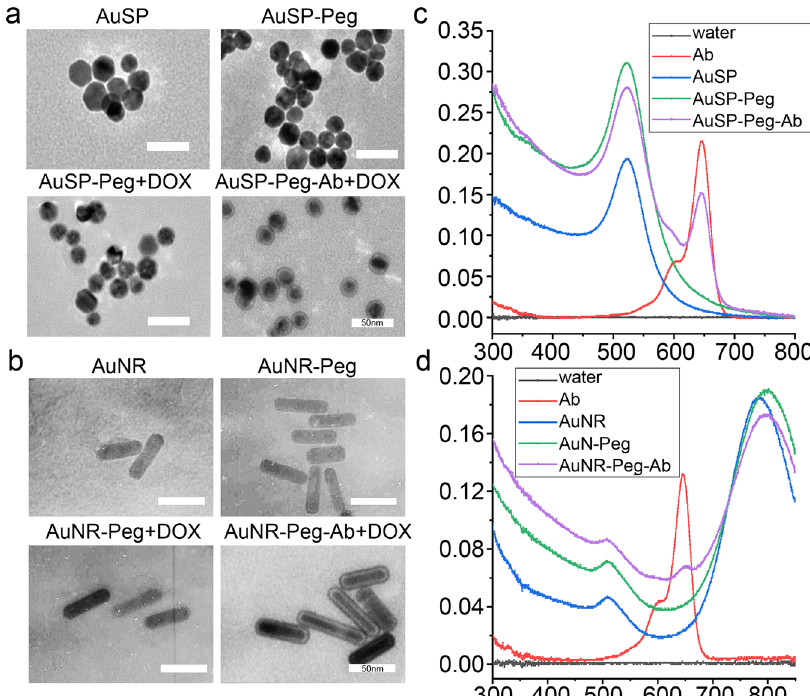
Fig. 2 Gold nanoparticles characterization by TEM and spectrum. a , b Representative images of TEM detection for gold nanosphere and nanorods (AuSP and AuNR), Au-PEG, Au-PEG + DOX with or without linking by Ramucirumab (Ab). c , d Spectrum measured red shift when Au modi fi ed by PEG and